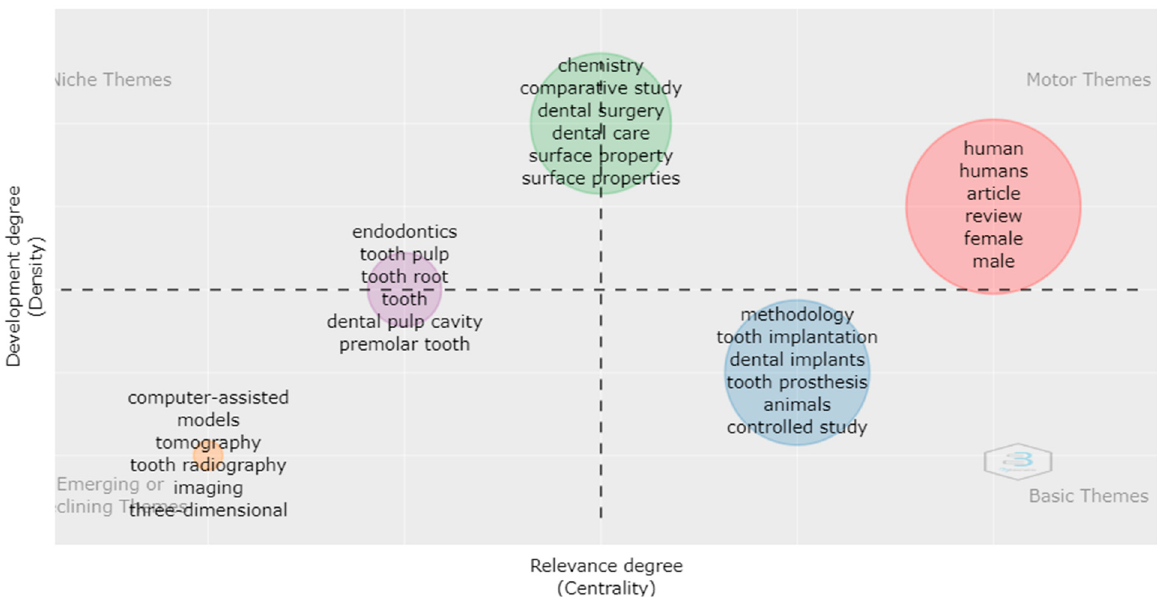
Figure A3. Conceptual Structure. World Dentistry Thematic Map (1996–2020) generated with Bibli-